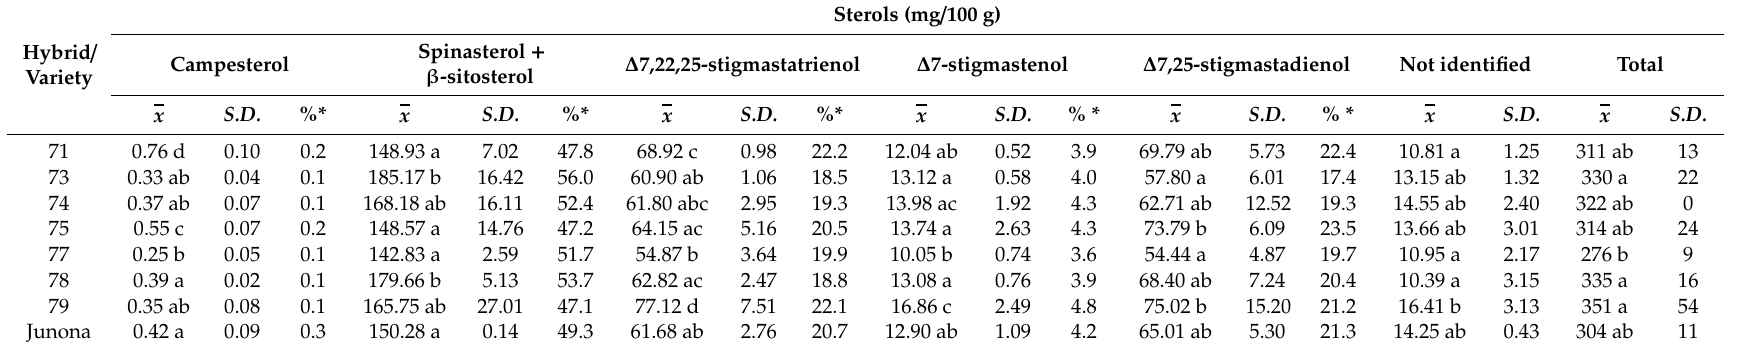
Table 4. Sterol content in total content of lipids from seeds of studied Styrian oil